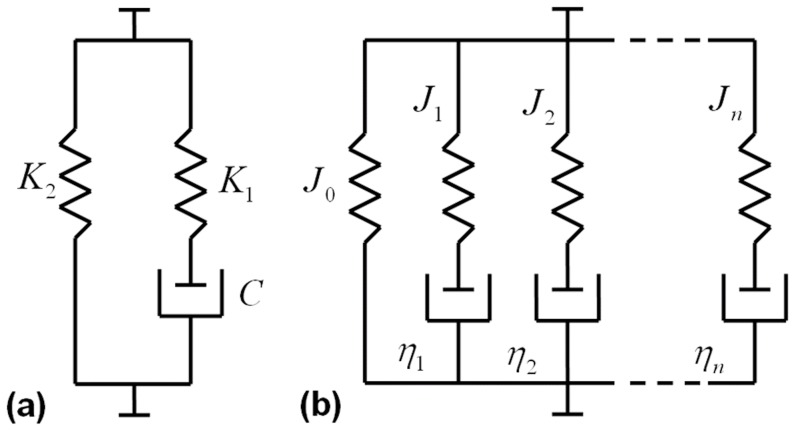
Illustration of two Kelvin-solid models: (a) SLS model (b) Prony Series model.Each spring and damper in series represents a Maxwell model. For clarity, linear rather than rotational components are illustrated.